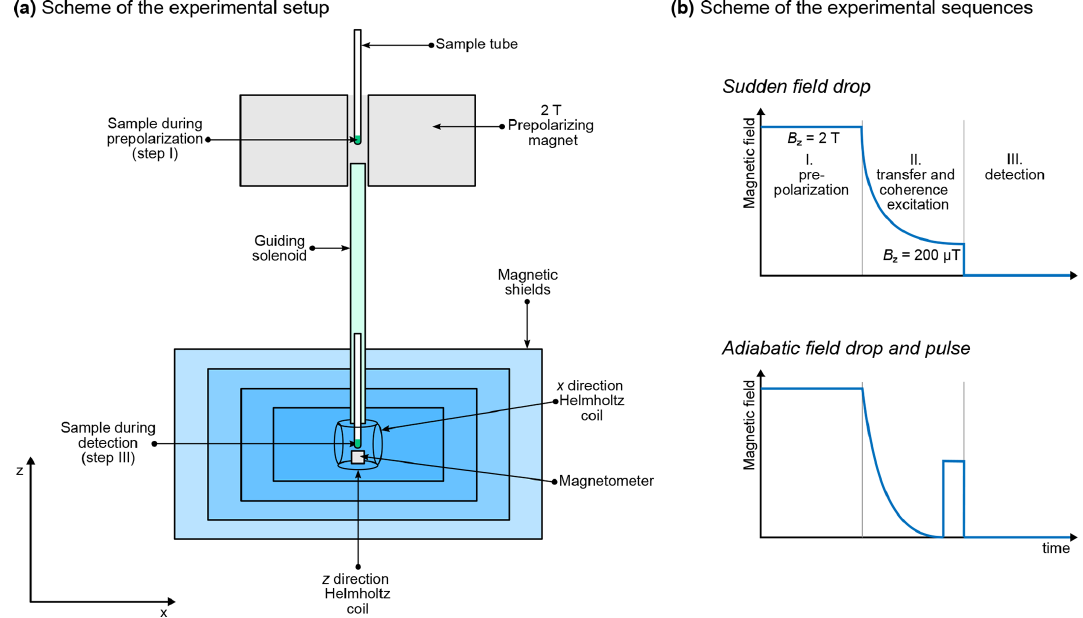
Figure 1. (a) Typical experimental setup for ZULF experiments. Note that the sample is represented in two places in the same drawing even if there is a single sample. (b) Schemes of the experimental sequences for measurements at ZF using a sudden field drop or an adiabatic field drop followed by a pulse of static magnetic